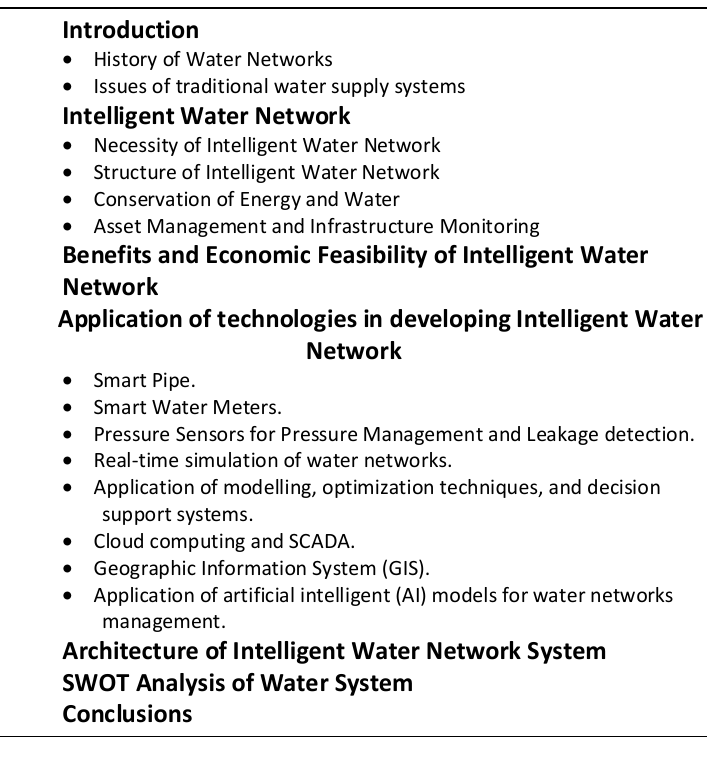
Figure 1. Structure of Review Paper .